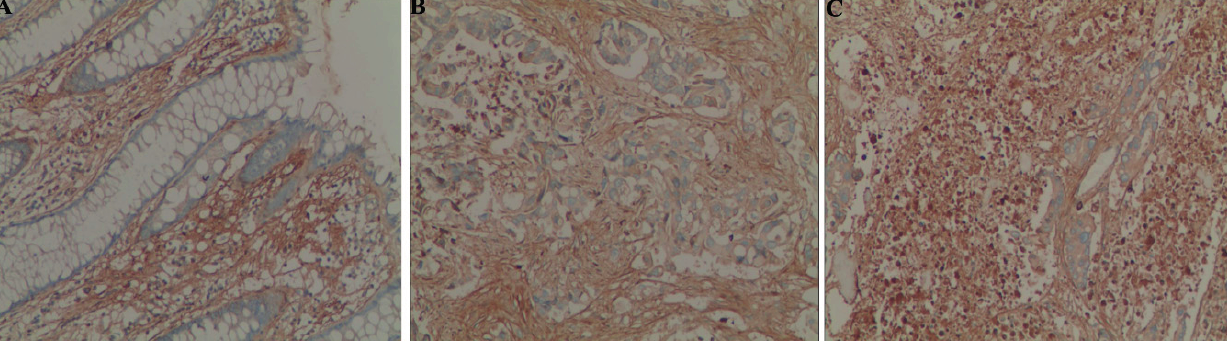
Figure 1. Immunohistochemical staining of POSTN protein in colorectal cancer and normal mucosa cells (original magnification, ×200). ( A ) POSTN is negative in normal colorectal mucosa; ( B ) Low levels of POSTN expression in colorectal cancer cells; and ( C ) High levels of POSTN expression in colorectal cancer